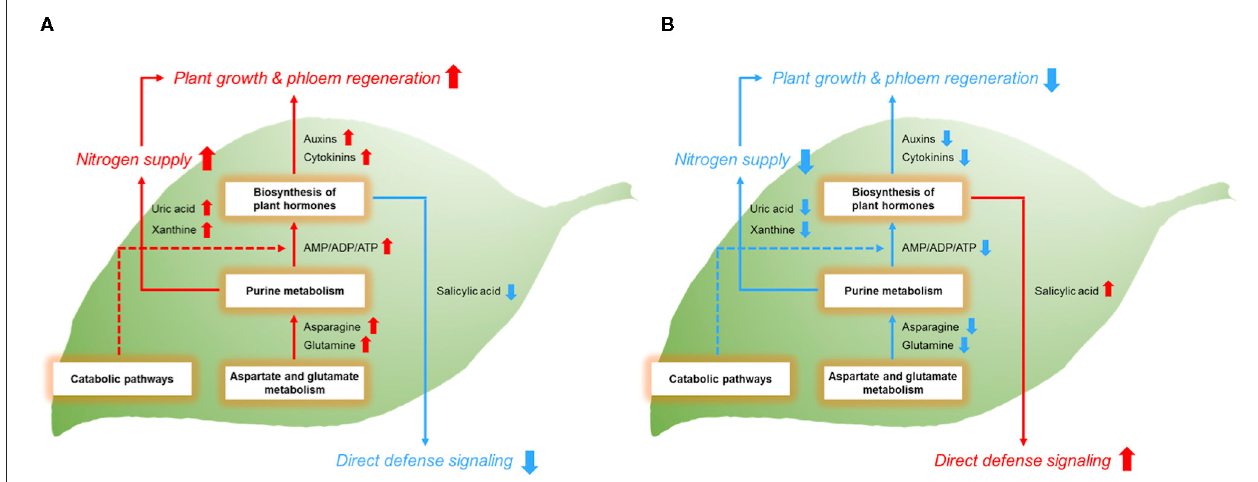
FIGURE 5 | Metabolic mechanisms of (A) HLB-tolerant and (B) HLB-sensitive citrus hosts and physiological consequences. Red arrows represent the relative upregulation of metabolic responses or functional activities. Blue arrows represent the relative downregulation of these features. The dotted line indicates the metabolic pathway that needs to be further